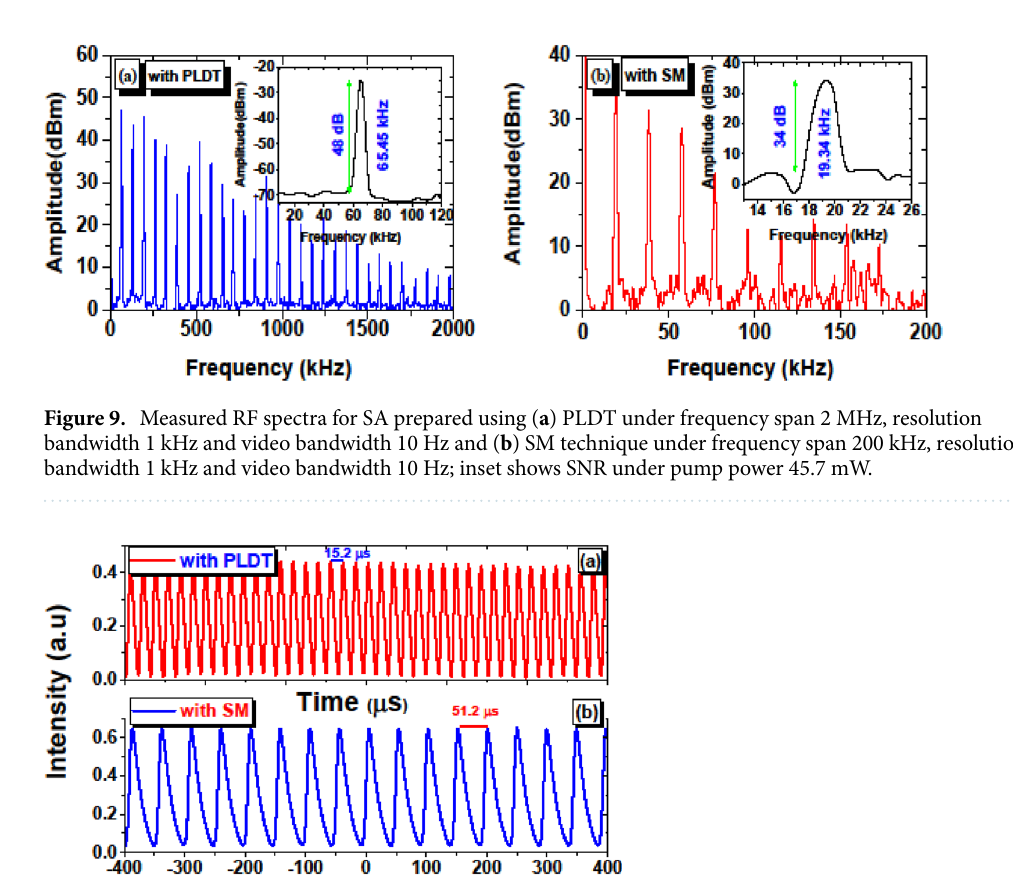
Figure 8. Measured ( a ) pulse repetition rates for SA prepared using SM (hollow red circles) and PLDT (solid blue circles) and ( b ) pulse width for SA prepared using SM (hollow red circles) and PLDT (solid blue circles) as a function of pump power.